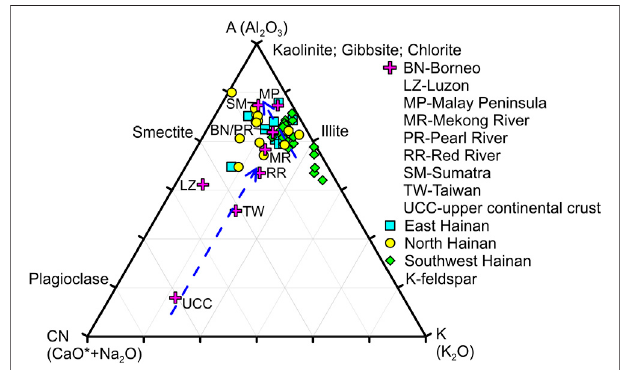
FIGURE 4 | A – CN – K diagram showing the weathering trends of the Hainan riverine sediments. Average data of UCC (Rudnick and Gao, 2003), Luzon (Liu et al., 2009), Taiwan rivers (Selvaraj and Chen, 2006), Red, Mekong, and Pearl (Liu et al., 2007), Borneo (Liu et al., 2012), Sumatra